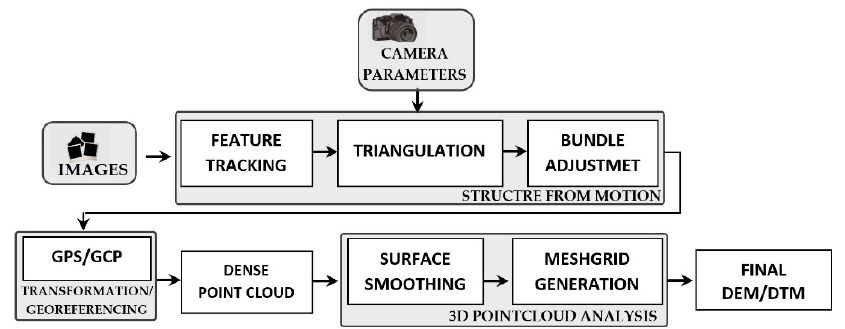
Figure 5. Workflow for generating point-cloud using UAV photogrammetry [35].